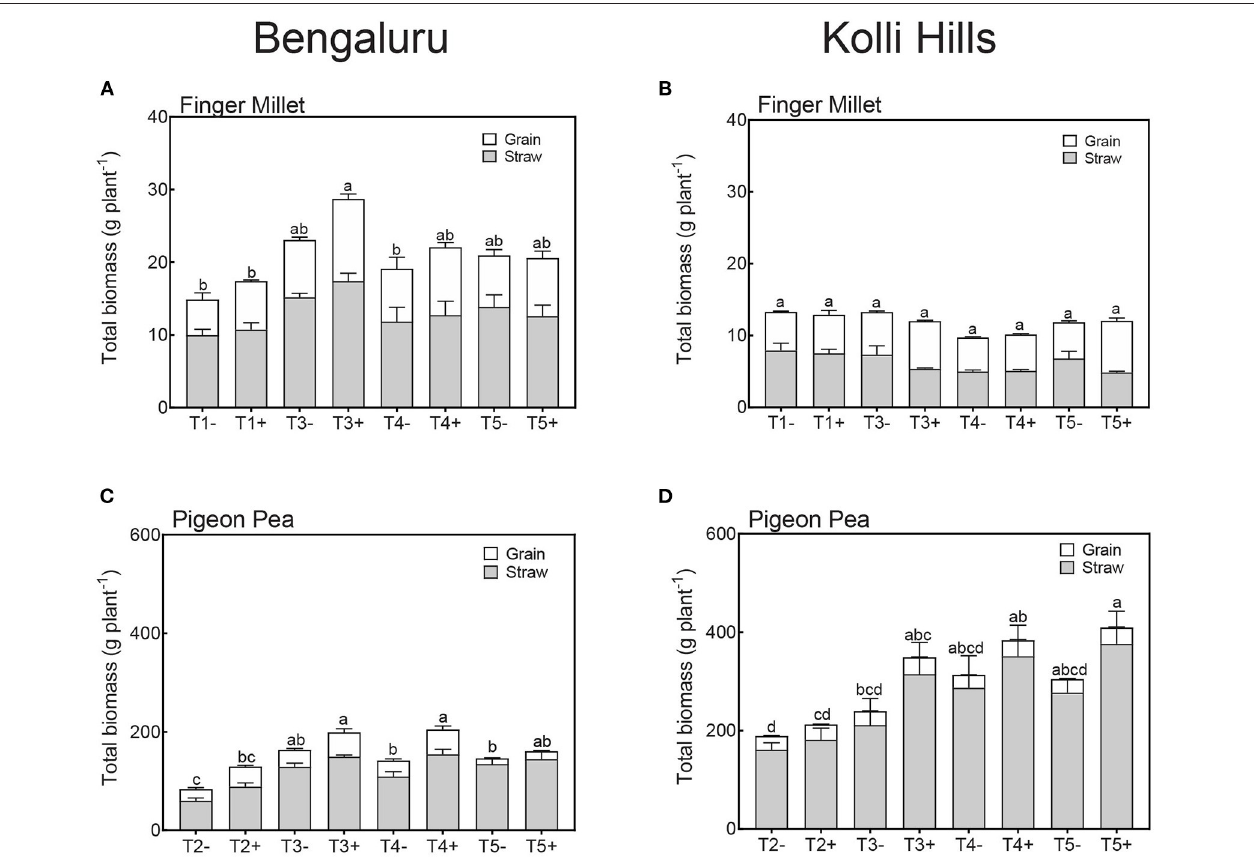
FIGURE 7 | Total biomass per plant of FM and PP at Bengaluru (A,C) and Kolli Hills (B,D) during 2017/18 field trial. Bars represent the average of four replicates with standard error of mean. One-way ANOVA followed by Tukey‘s test ( post-hoc test) was used for the combined biomass of grain and straw, separately for each site, and values with same letters are not significantly different from each other at p >